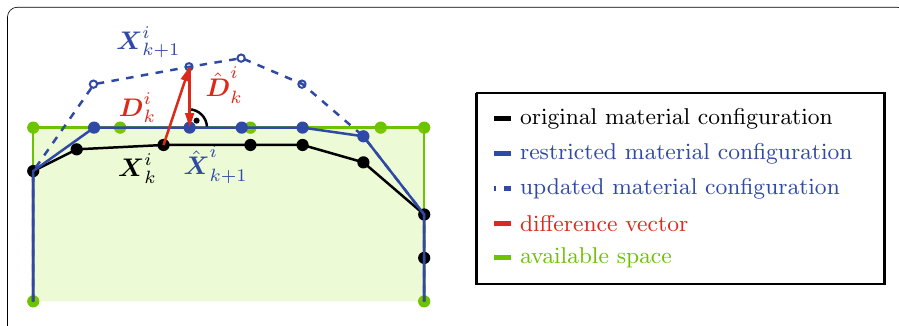
Fig. 9 Restriction of an updated material configuration (dashed blue) to the available space (green)